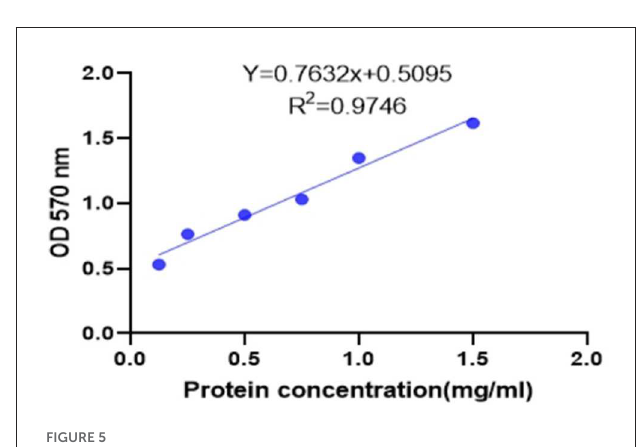
FIGURE5 Protein concentration standard